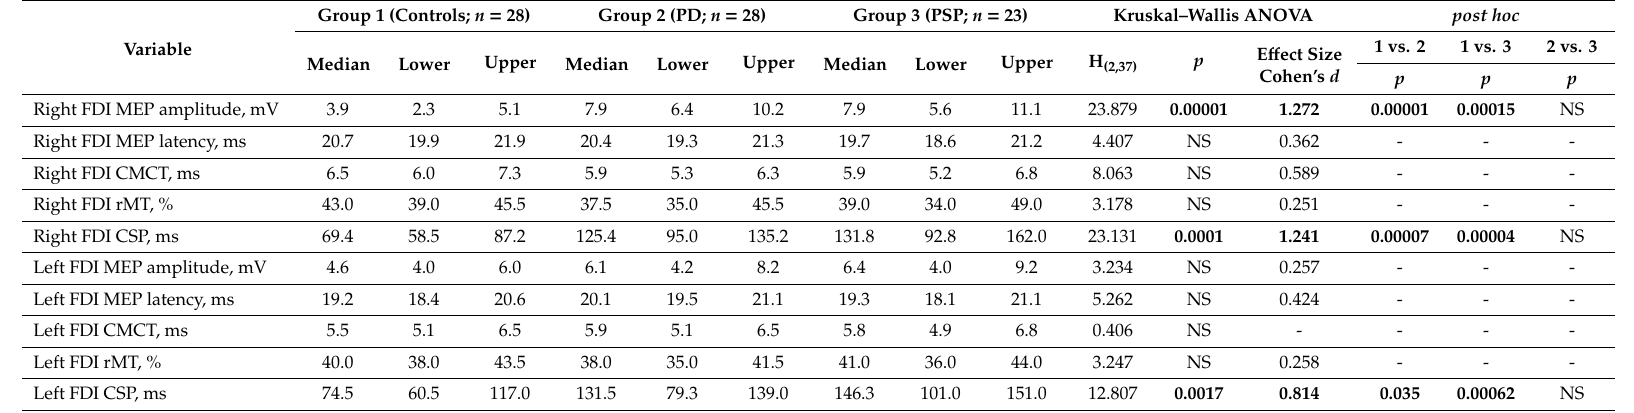
Table 2. Single-pulse transcranial magnetic stimulation (TMS) data obtained from all